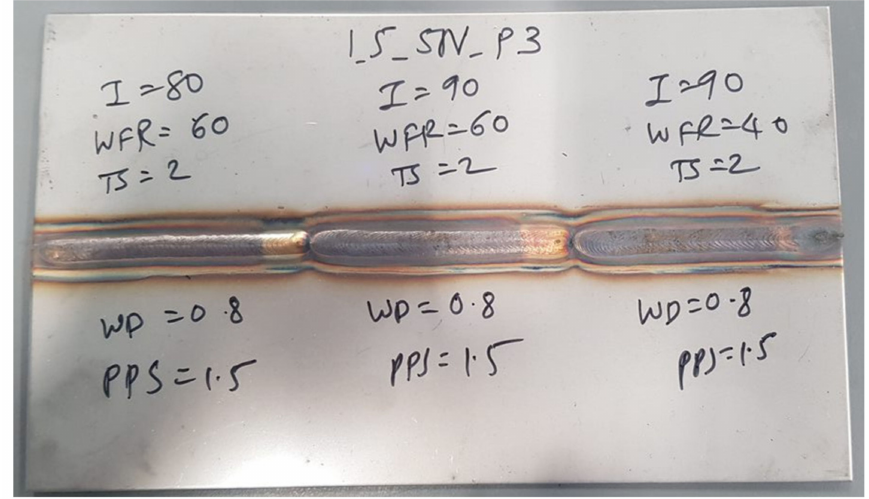
Figure 2. Three welds made on every pair of sheets using different